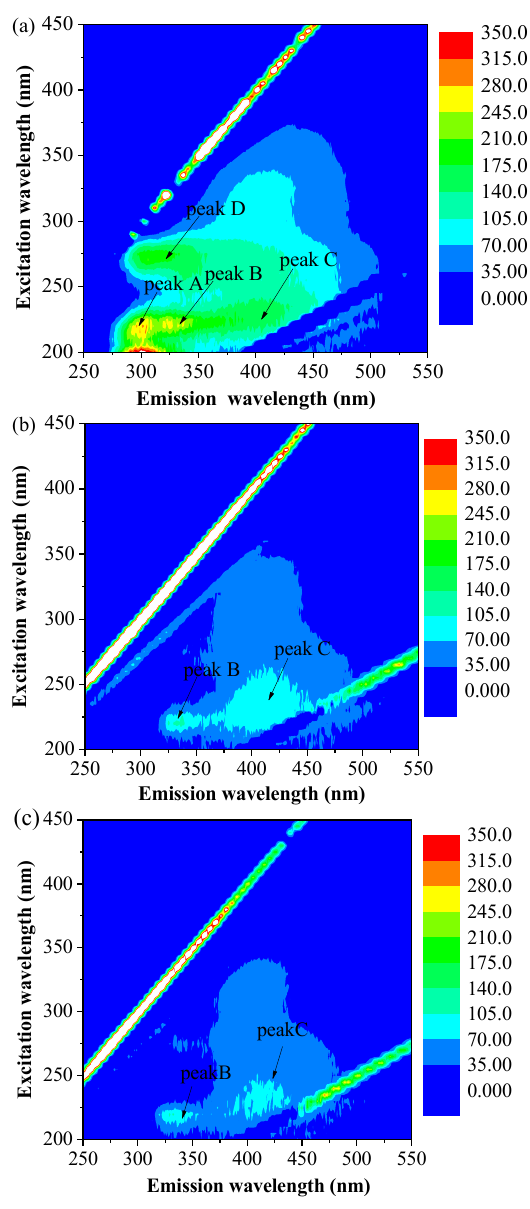
Figure 6. The effects of filtration modes on fluorescent excitation-emission matrix (EEM) in the water samples: ( a ) raw water, ( b ) average results in the permeates of two SGDMs, ( c ) average results in the permeates of two CGDMs. Table 3. Effects of filtration modes on fluorescent peak intensity of EEM